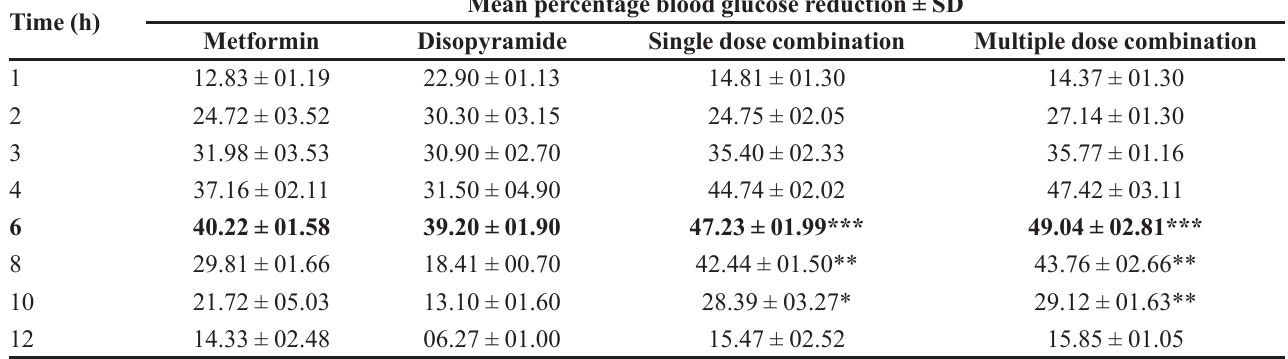
TABLE II - Percentage blood glucose reduction after oral administration of metformin 18 mg/200 g body weight, disopyramide 3.6 mg/200g body weight, disopyramide single dose study and multiple dose study in diabetic rats (n=6) Time (h)